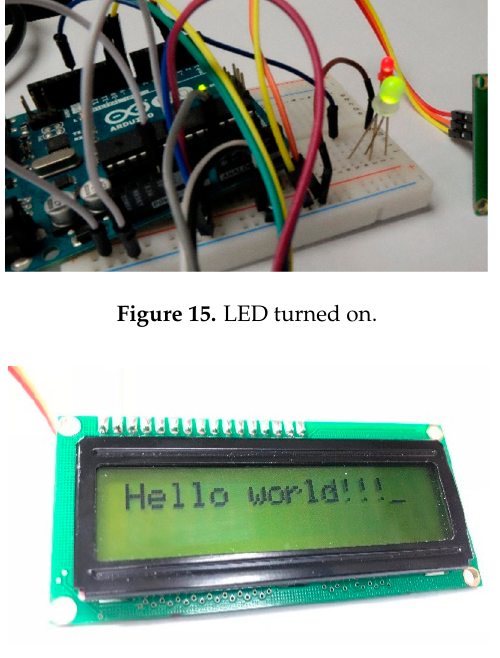
Algorithm 6. An example task to display text on the LCD monitor.